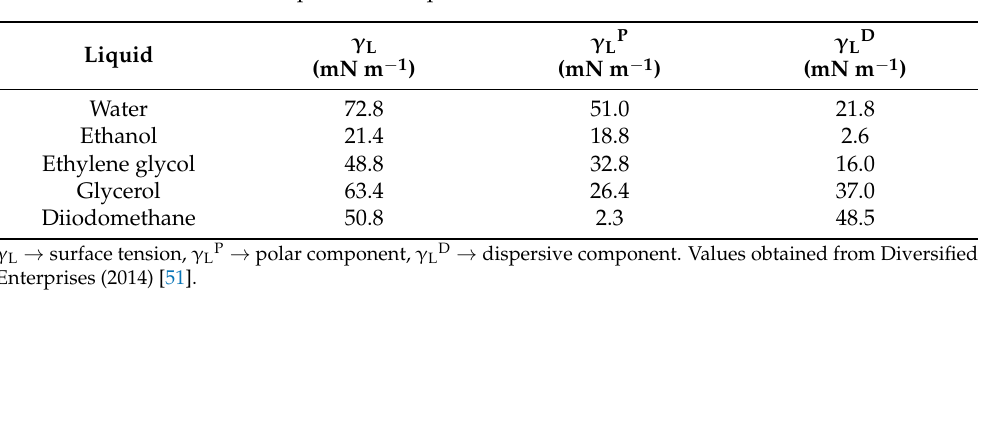
Table A1. Surface tension components of